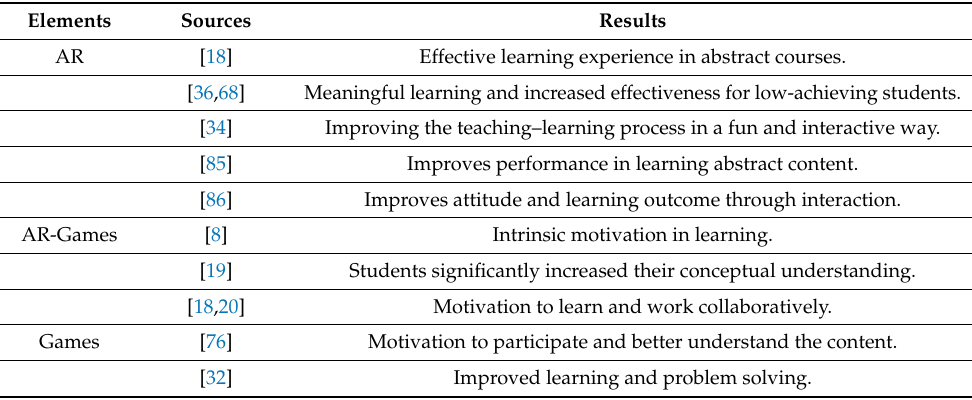
Table 2. Technologies for learning and enjoyable